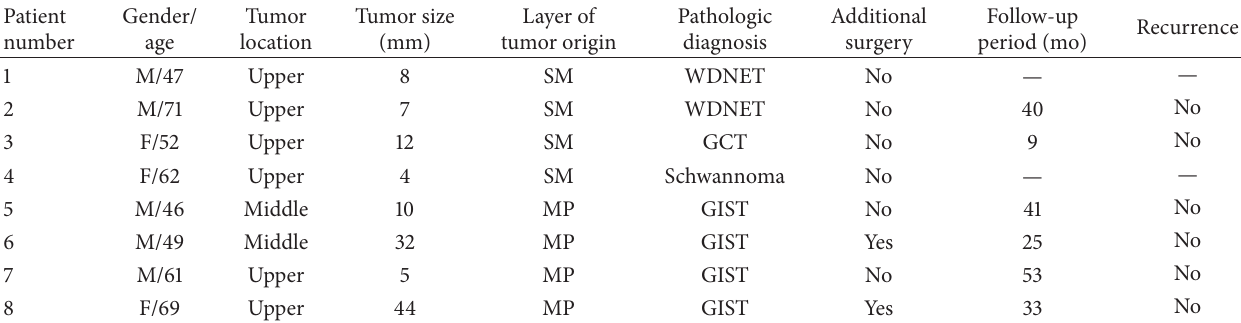
Table 5: Clinicopathologic characteristics of gastric subepithelial tumors incompletely resected by endoscopic submucosal dissection.